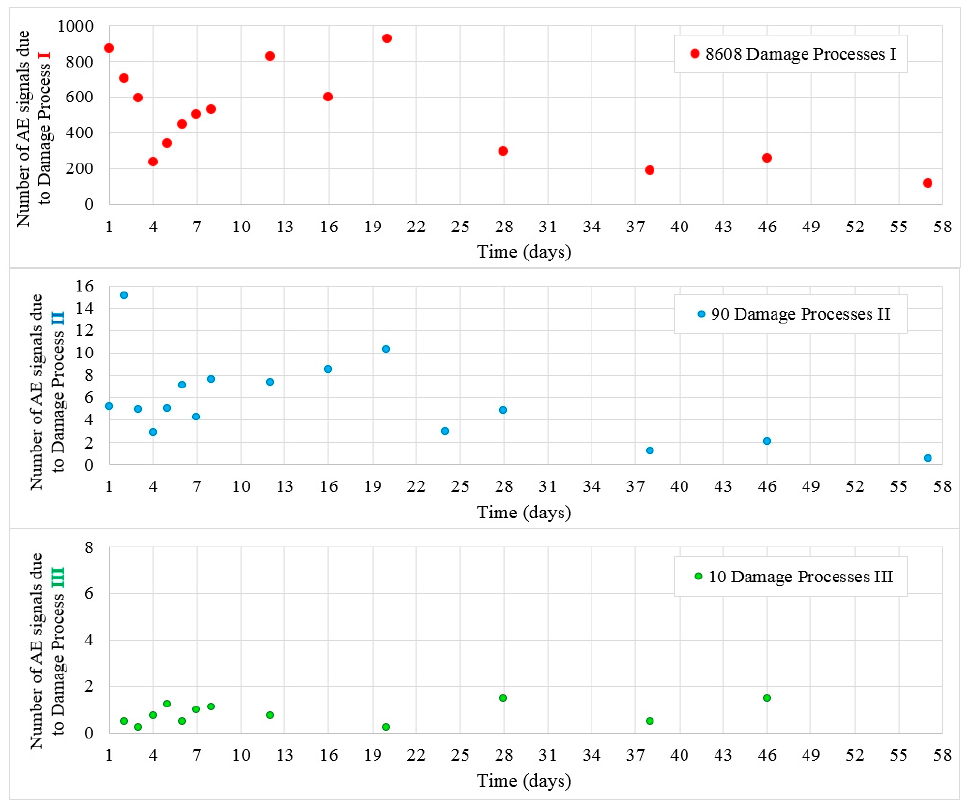
Figure 7. Number of damage processes I–III obtained from W4 samples.